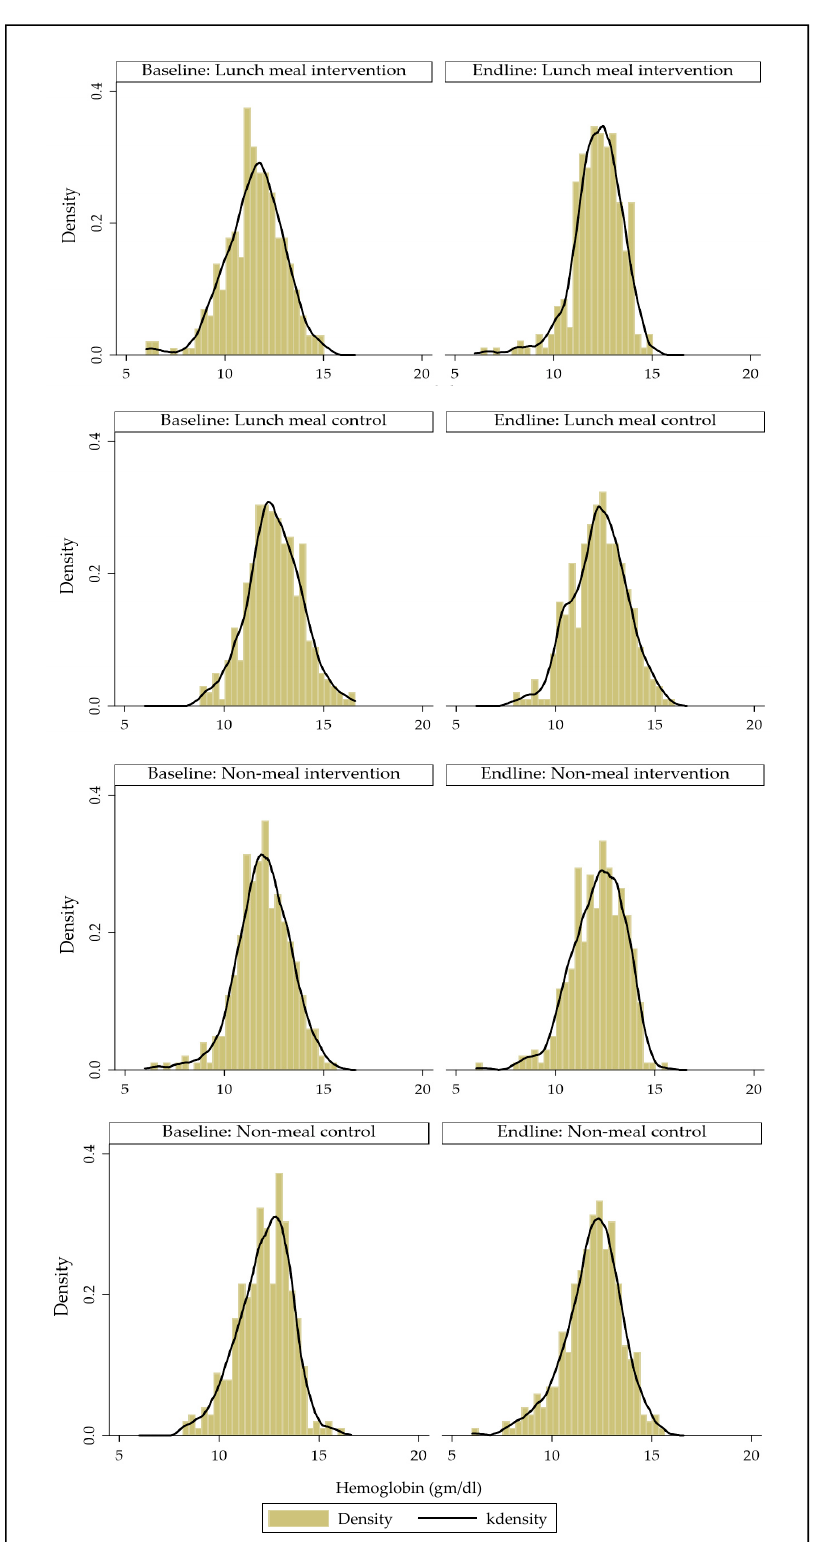
Figure 2. Distribution of hemoglobin at baseline and endline in each group (histogram with kernel density